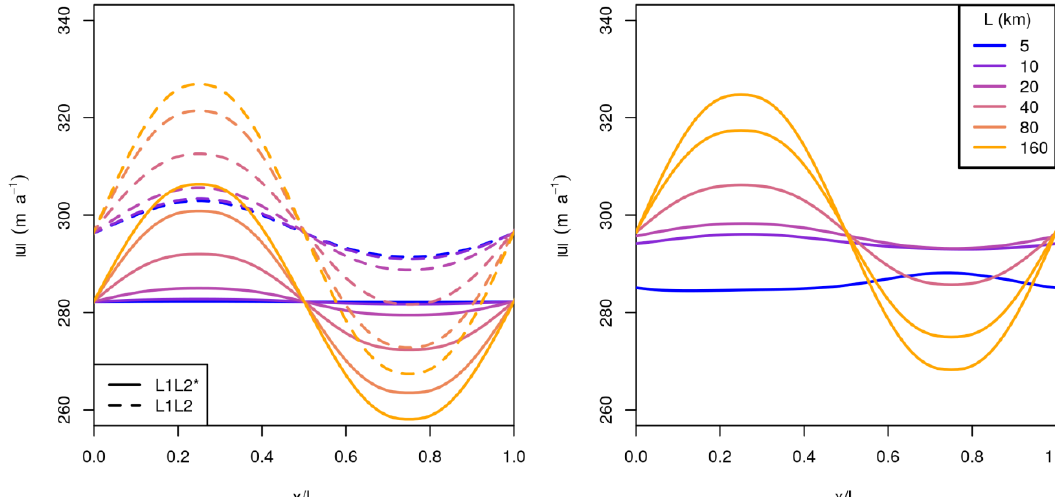
Figure A1. BISICLES and Elmer/Ice vertically averaged speeds for a periodic flow line problem. BISICLES speeds (left, L1L2*) have the same horizontally averaged values for all undulation wavelengths ( L) , while the amplitude of the oscillation in speed decays with L . The same is true for the complete L1L2 approximation, though that still produces appreciable oscillation at all values of L . Elmer/Ice (right) shows an intermediate decay in amplitude but also a reduction in the average speed at the smallest L .